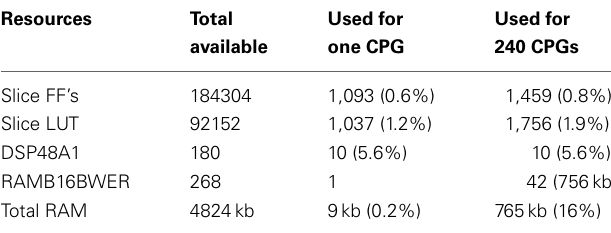
Table 4 | Resources required for one CPG on a Spartan 6 digital